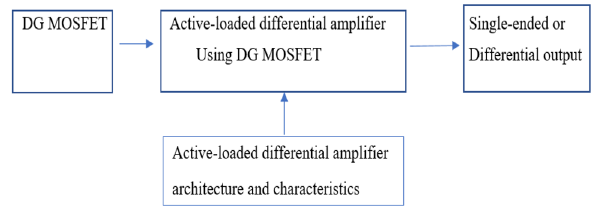
Fig. 1 Process for the design of DG MOSFET-based differential amplifier